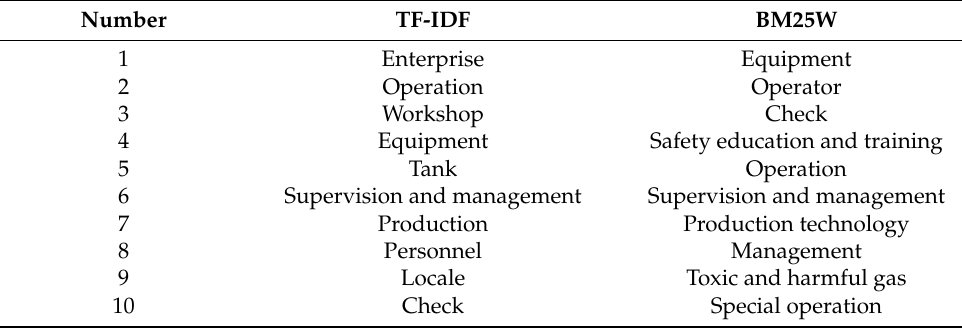
Table 4. The top 10 keywords extracted by TF-IDF and